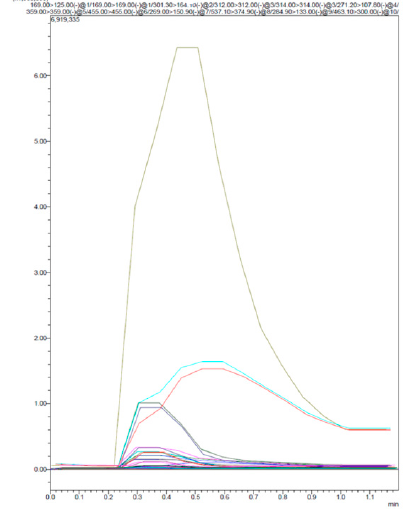
Table 3. LC/MS-MS identified composition of OMP.